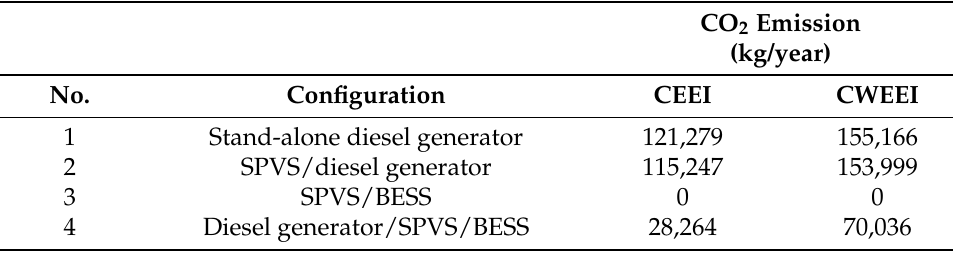
Table 9. Average CO 2 emissions produced in the configurations over the planning